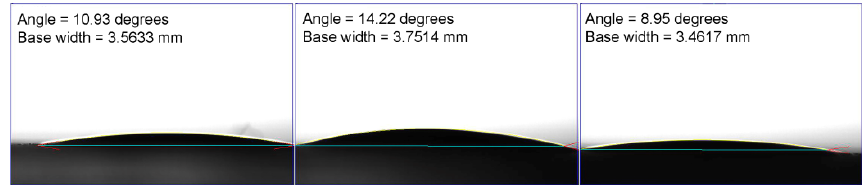
Figure 3. Contact angle of pectin hydrogel enriched with allantoin.